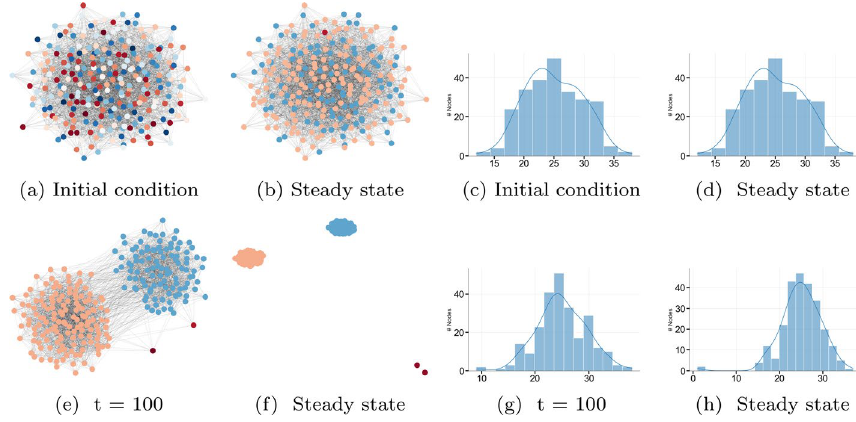
Fig. 5 Example of the effects of the adaptive topology on the Adaptive Algorithmic Bias Model on the Erdős–Rényi graph with γ = 0.0 . An example of the effects of the co-evolution of network structure and opinions in the Adaptive Algorithmic Bias model on the Erdős–Rényi graph for ǫ = 0.2 , p r ∈ { 0.0,0.5 } and γ = 0.0